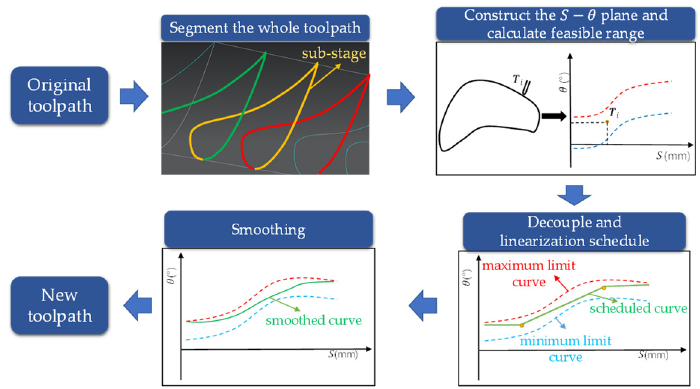
Figure 1. Flow chart of specific steps of the proposed method.